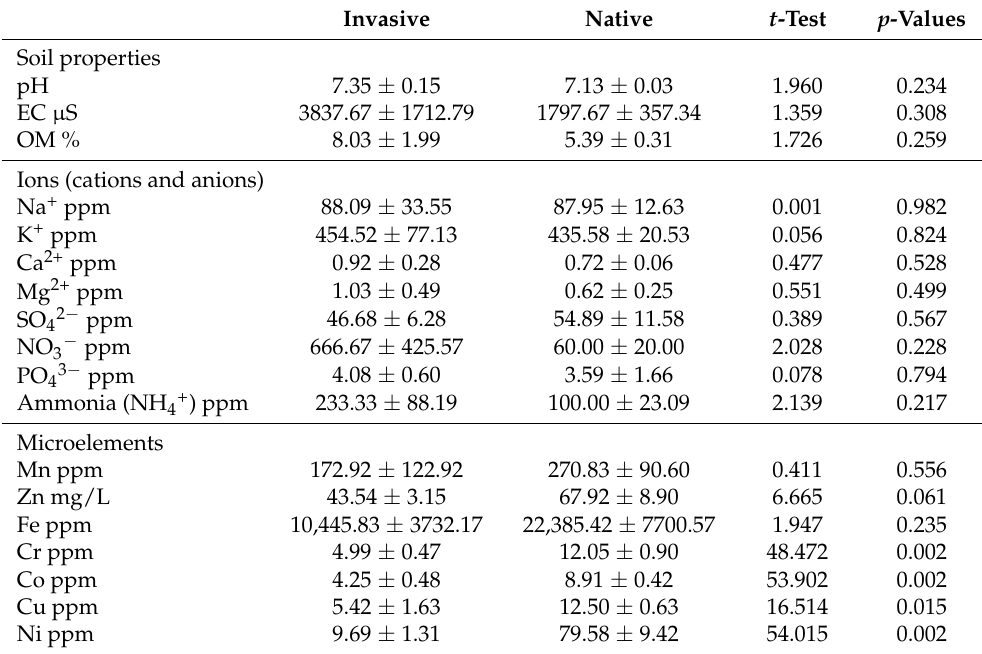
Table 1. Soil properties, ion concentrations, and microelement concentrations of soils in stands invaded by Prosopis juliflora and adjacent stands with native vegetation in southwest Saudi Arabia.